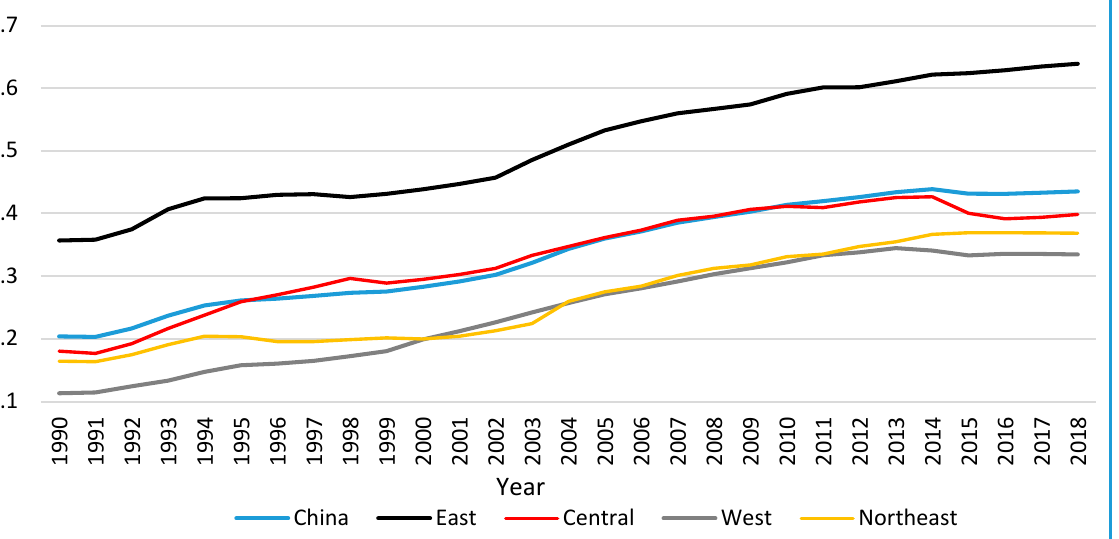
Figure 1. The evolution of the labor transfer from 1990–2018 at the regional and country levels.